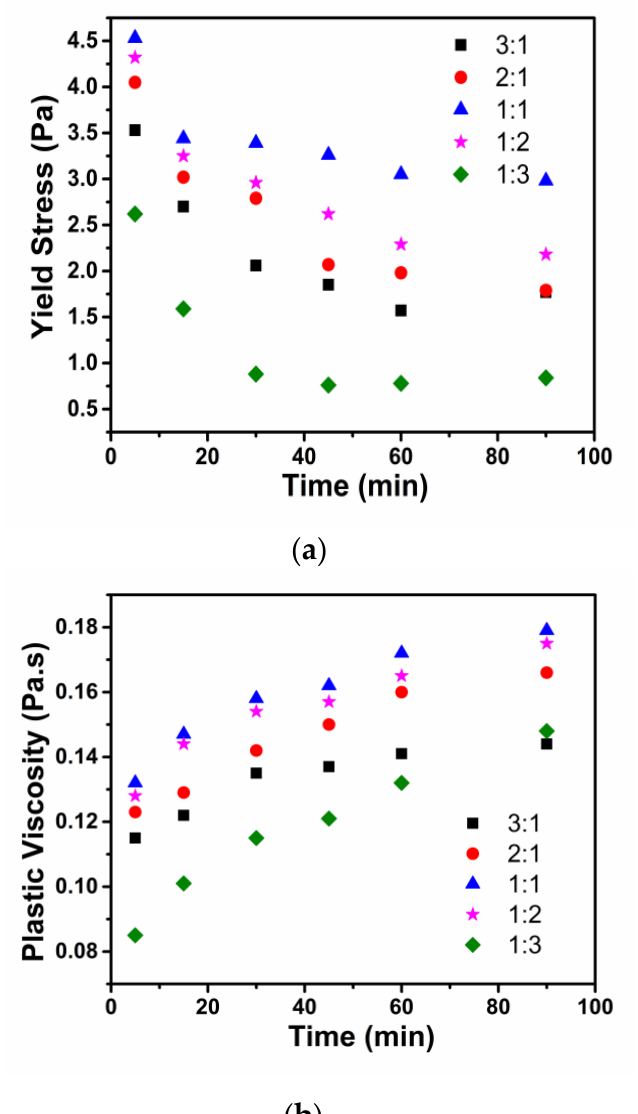
Figure 4. Effect of charge density of AMPS – DMAA copolymers on ( a ) yield stress and ( b ) plastic viscosity of cement paste.